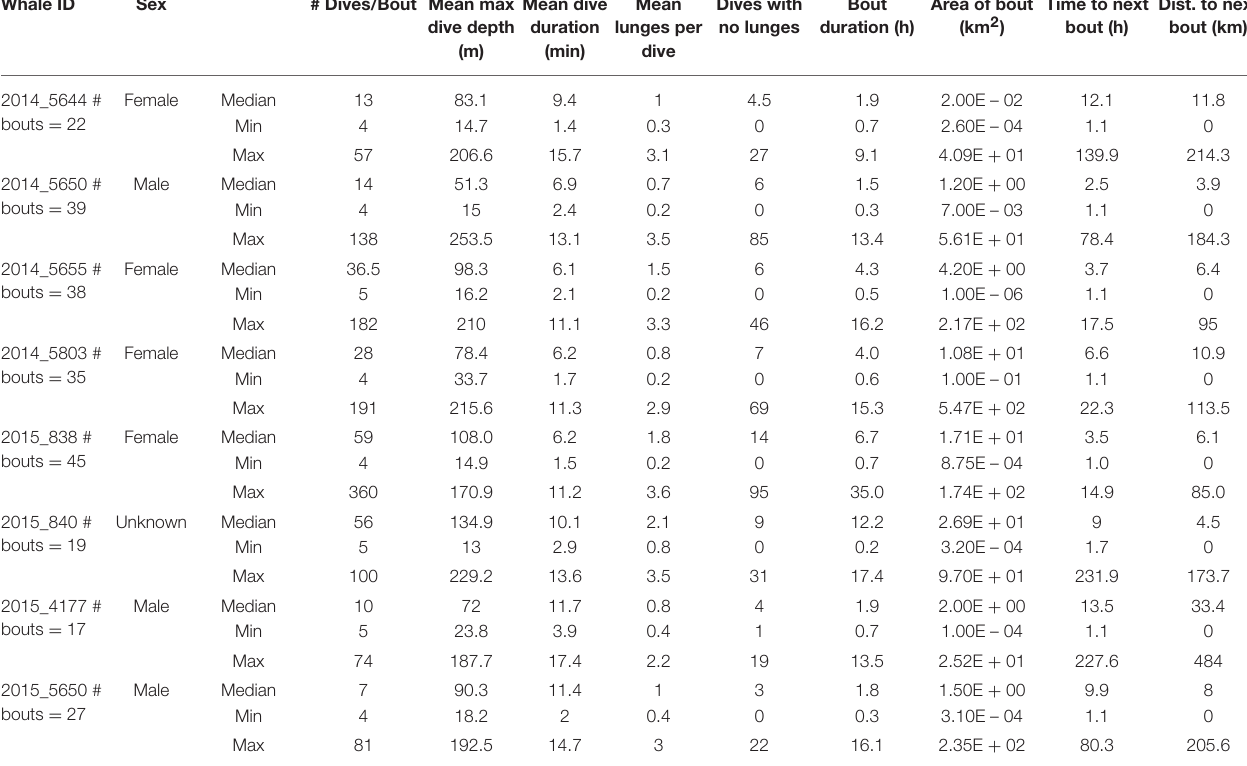
TABLE 2 | Summary of dives occurring during feeding bouts made by eight blue whales instrumented with ADB tags off southern California in August 2014 and July 2015. Whale ID